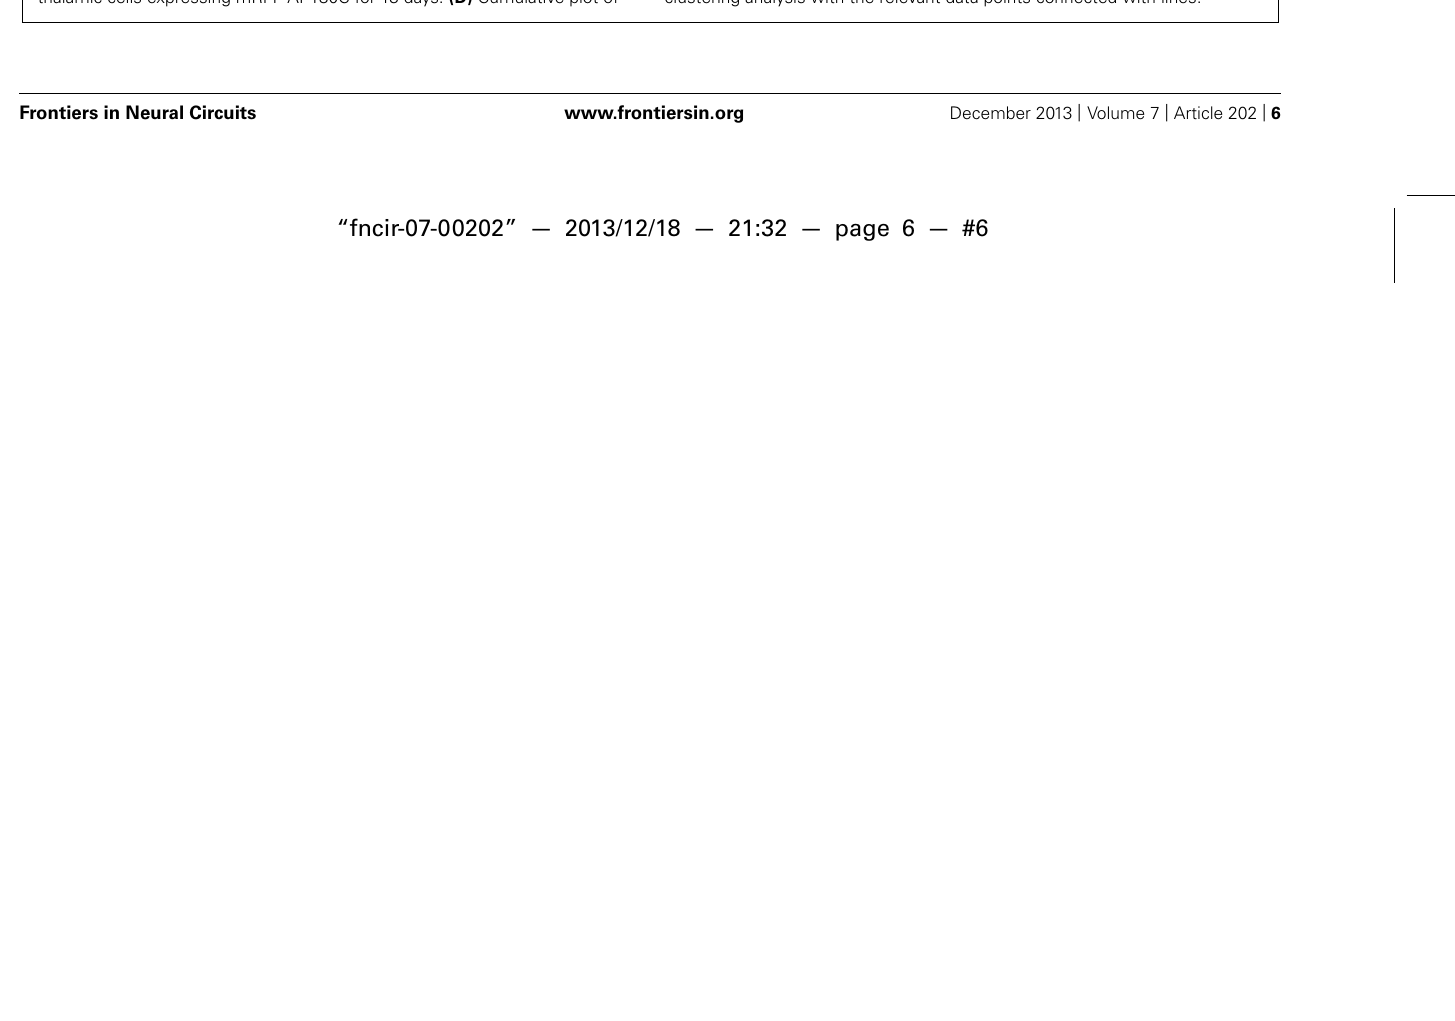
the branch-point location with respect to the pial surface for doxycycline-induced mRFP-AP180C-expressing axons (red) and controls (gray). (E) Average number of branch points for doxycycline-exposed controls and induced mRFP-AP180C-expressing cells.When mRFP-AP180C- expressing cells were divided into two groups according to a k-means clustering algorithm (see panel F ), the group with low mRFP-AP180C fluorescence had fewer branch points than the controls.The error bars represent SEM. * P < 0.05 (ANOVA). (F) Number of branch points plotted against mRFP-AP180C fluorescence intensity.The black line illustrates opposing effects on branch number from two AP180C-mediated mechanisms using the sum of two sigmoid functions with opposite signs and parameters fit using least sum of squares. Large markers are centroids from a k-means clustering analysis with the relevant data points connected with